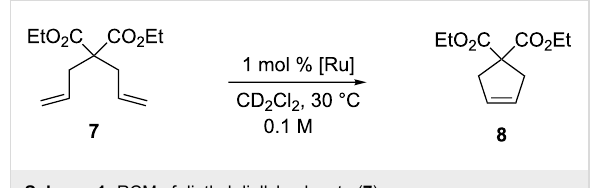
Scheme 1: RCM of diethyl diallylmalonate ( 7